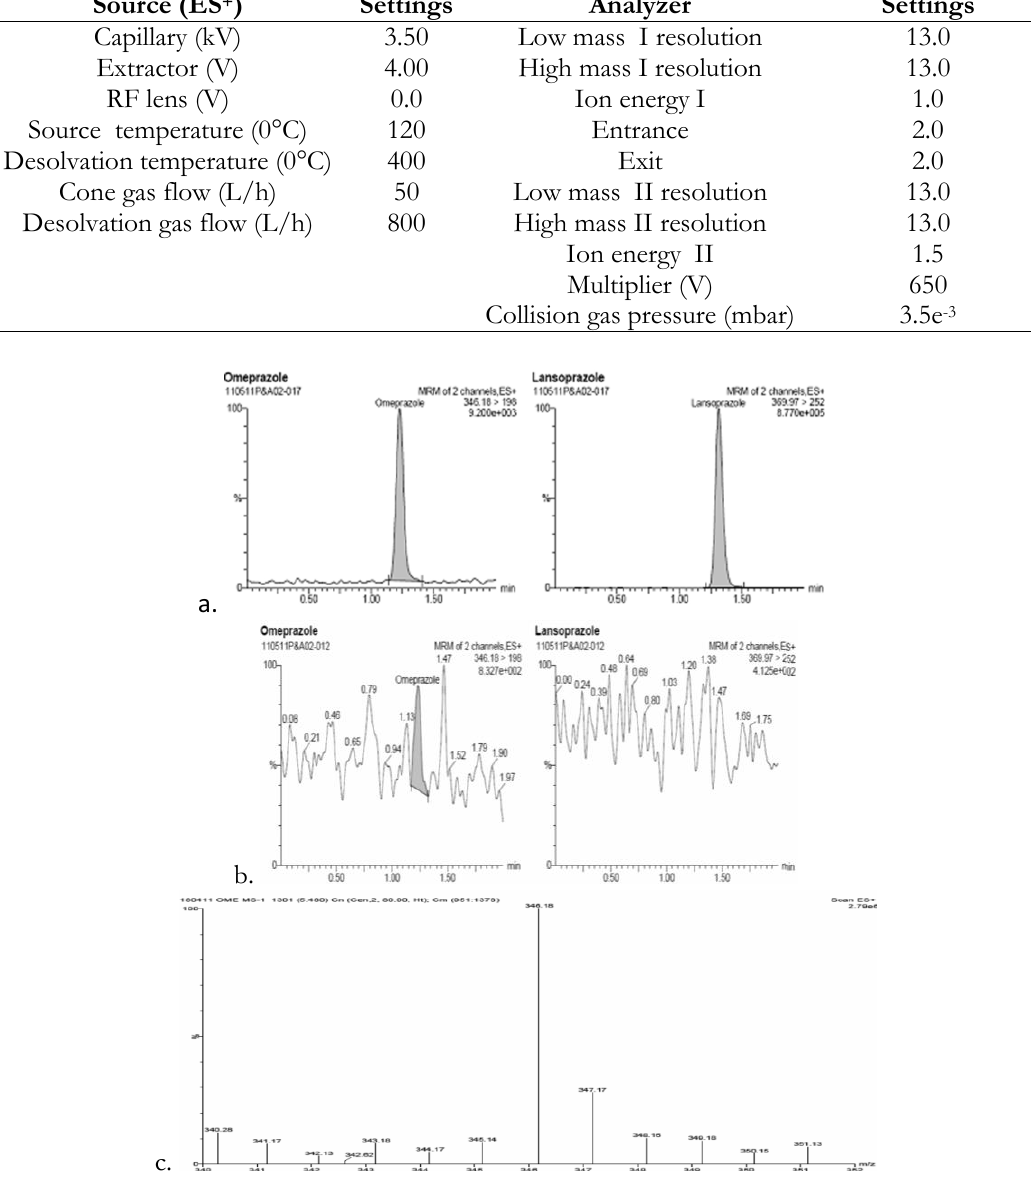
Figure 2. a Mass chromatograms of omeprazole and lansoprazole, b Mass Spectrum of omeprazole and lansoprazole, c Mass spectrum of